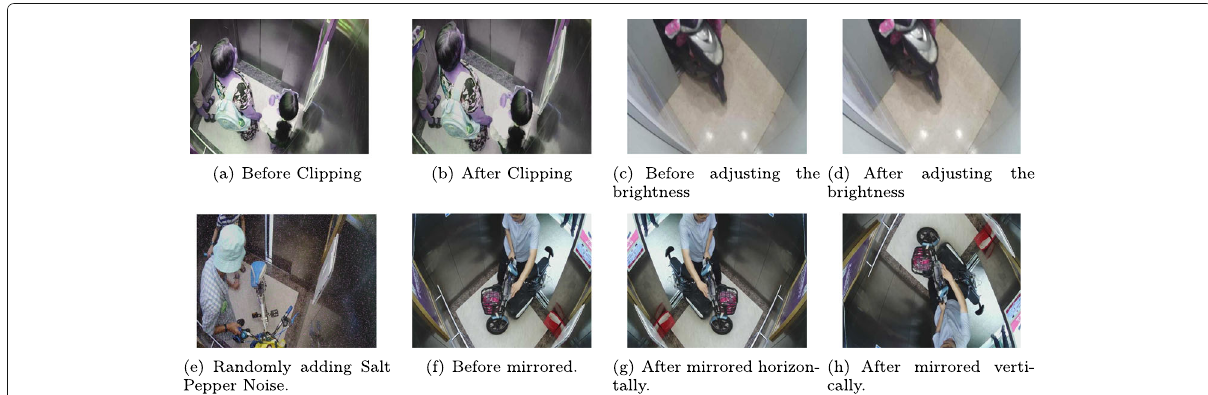
Fig. 4 Data Enhancements. Pictures a and b show clipping. Pictures c and d show brightness adjustment. Picture e shows the addition of noise. Pictures f to h show